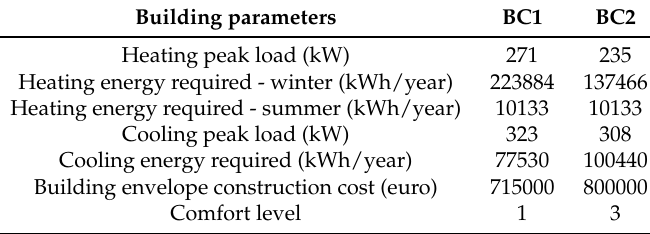
Table A1. Building parameters—building configuration.